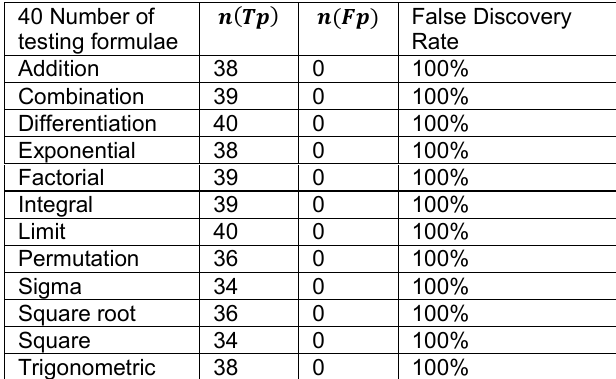
Table 23. The above tabulated value represents overall PPV Measure with Tensorflow from a document of 60 samples.